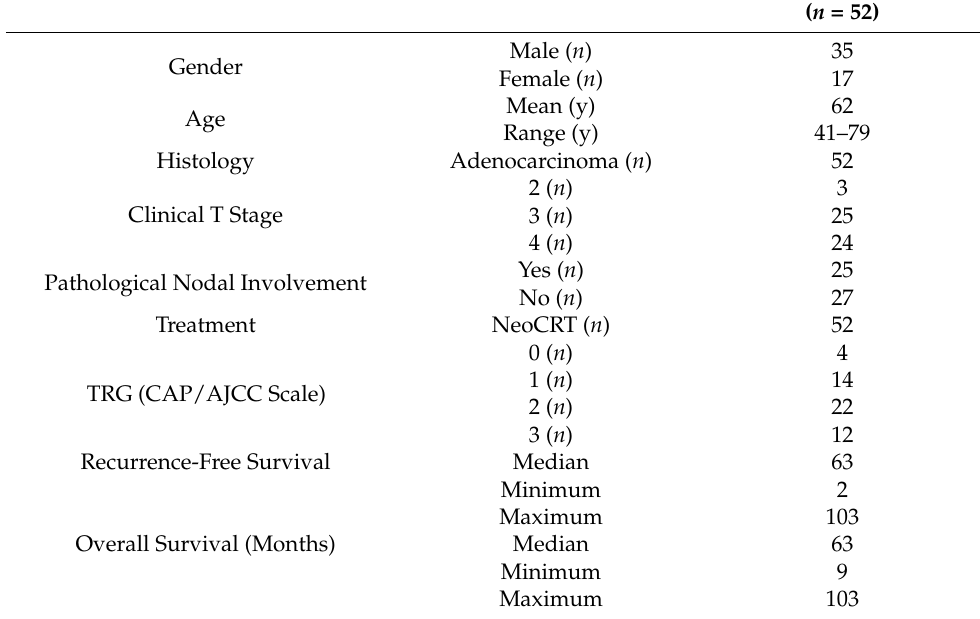
Table 2. Patient characteristics of rectal cancer patients used in metabolomic analysis of pre-treatment serum